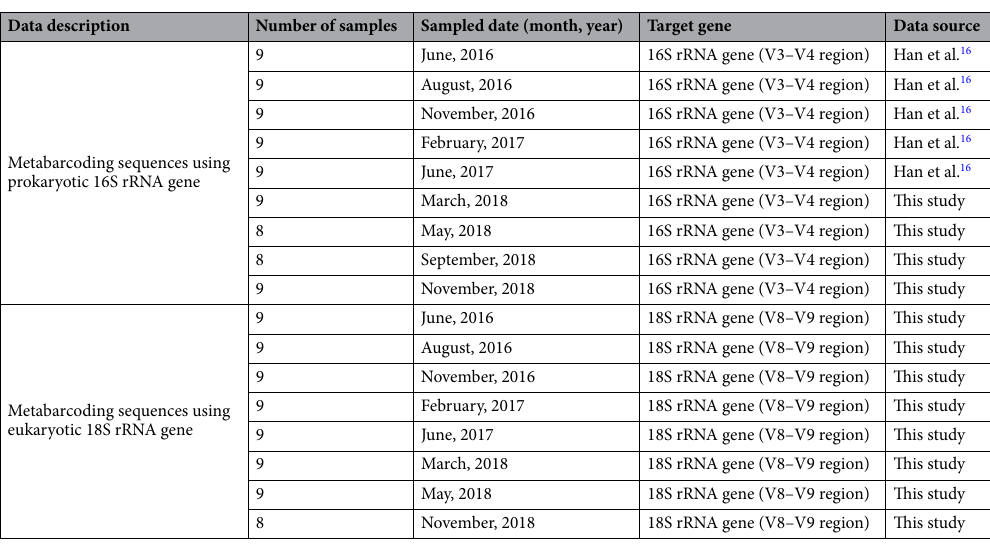
Table 1. Description of datasets in this